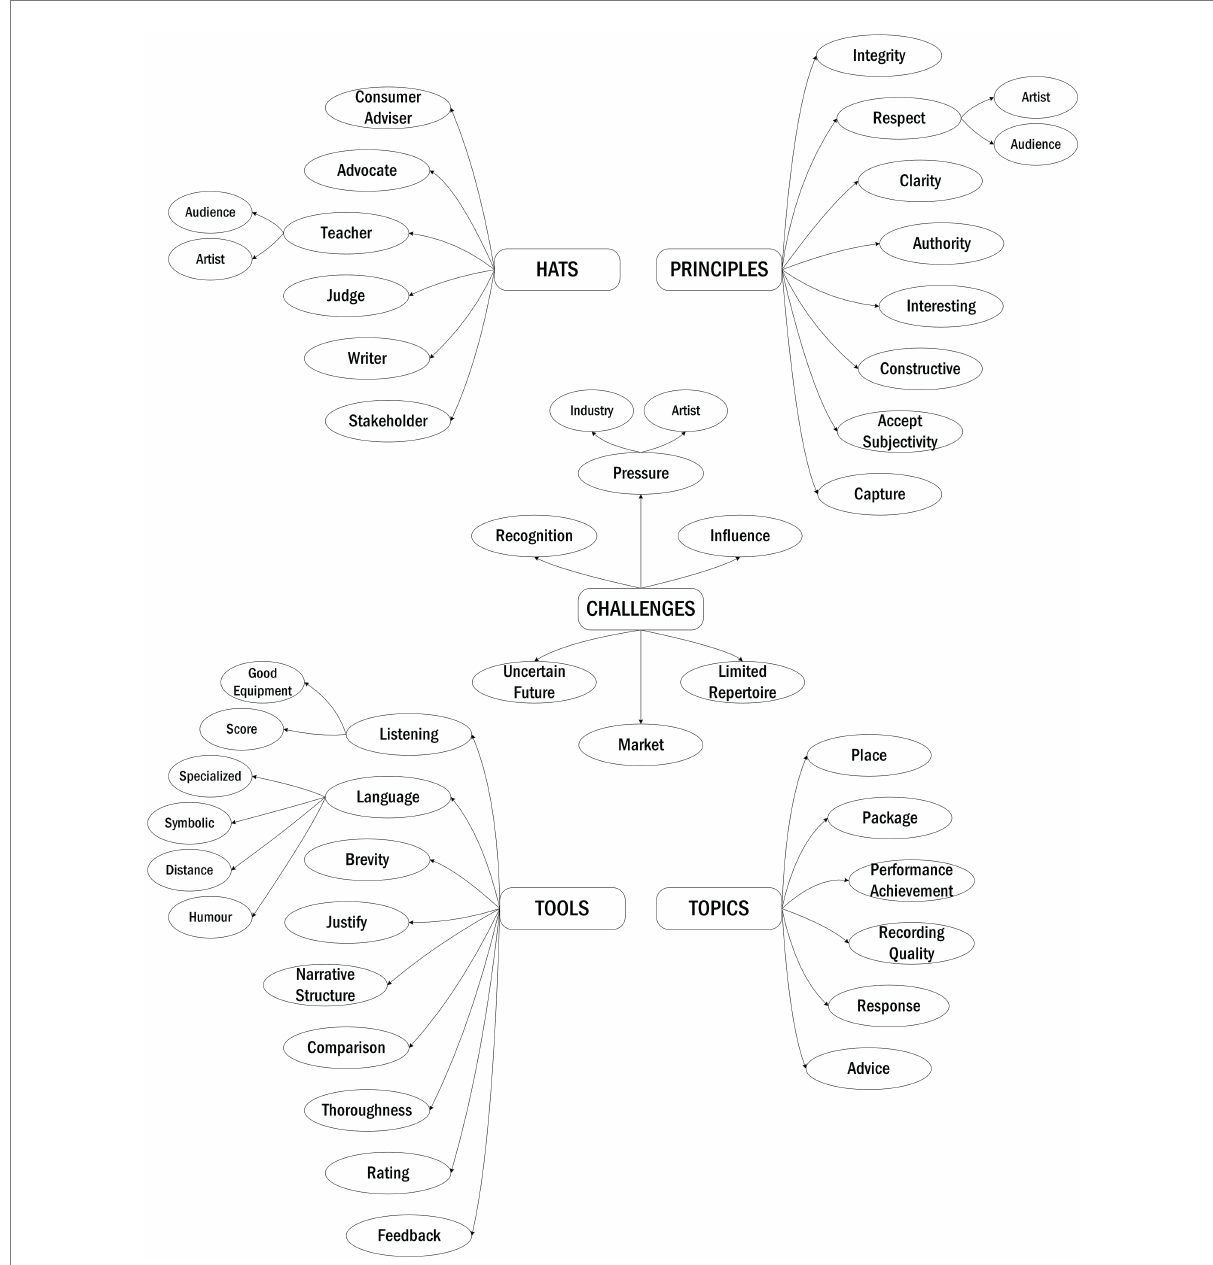
FIGURE 1 Visual model of the themes discussed by critics. Themes are organized hierarchically from rounded rectangles to ovals; arrows reinforce the visualization of this hierarchical